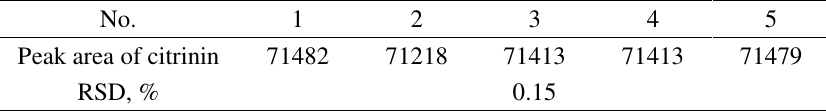
Table 3. The result of precision assay